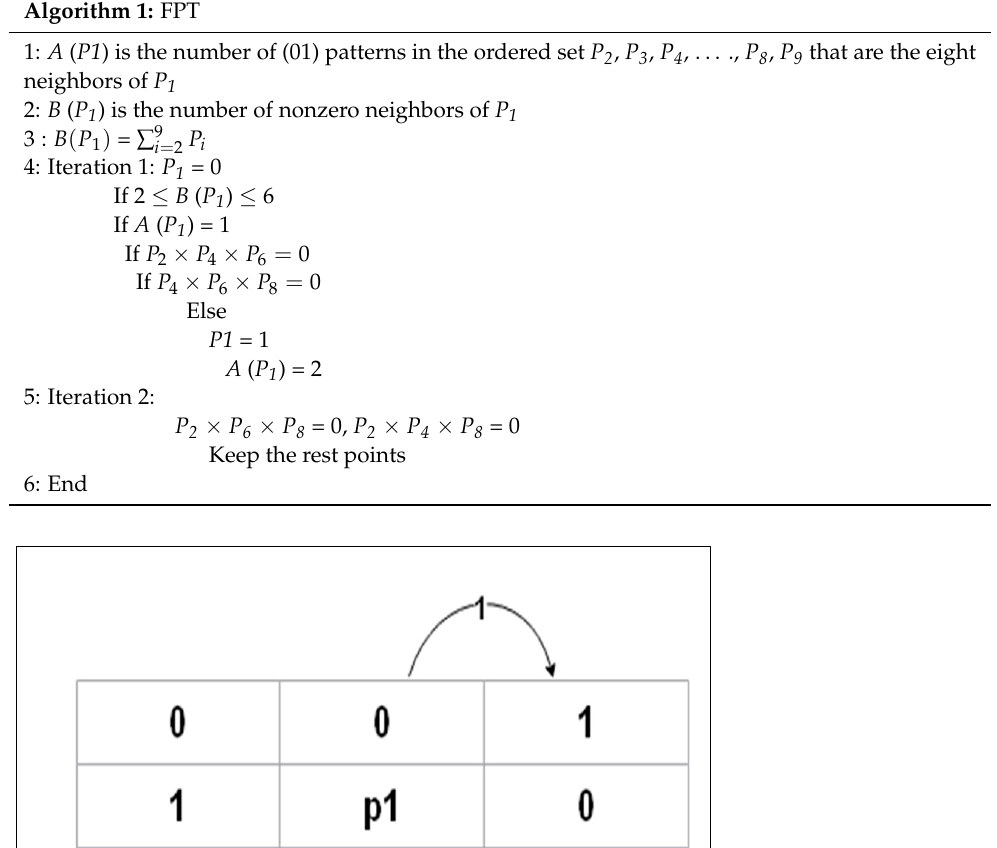
Figure 6. Preprocessing steps ( a ) grayscale image, ( b ) image denoising, ( c ) segmentation, ( d ) isolated removal, and ( e ) thinning and skeletonization. 3.2. Hybrid Feature Extraction Feature extraction is a crucial step in the verification of a signature. The proposed Hybrid Statistical Feature Extraction (HSFE) technique extracts highly informative features by combining multiple types of features using three statistical approaches: interest point features, global and local texture features, and curvelet transformation features. 3.2.1. Texture Feature In image processing, the texture is described as a function of the spatial variation of the brightness intensity of the pixel. Image processing is the primary term t o define objects or concepts in a given image. Texture analysis is critical in computer vision applications such as object recognition, surface defect detection, pattern recognition, a n d medical image analysis. This paper combines two statistical methods of edge direction matrices (EDMs) [ 4 4 ] and local binary pattern (LBP) [45] to extract texture attributes. LBP features are also known as the texture operator for a grayscale image, which helps to characterize the spatial structure of the input image texture. Once the central pixel value is obtained, the pattern code can be computed by comparing these values to its neighborhoods. It can be expressed as Formula (1). 𝐿𝐵𝑃 (cid:3015),(cid:3019) (cid:3404) (cid:3533)